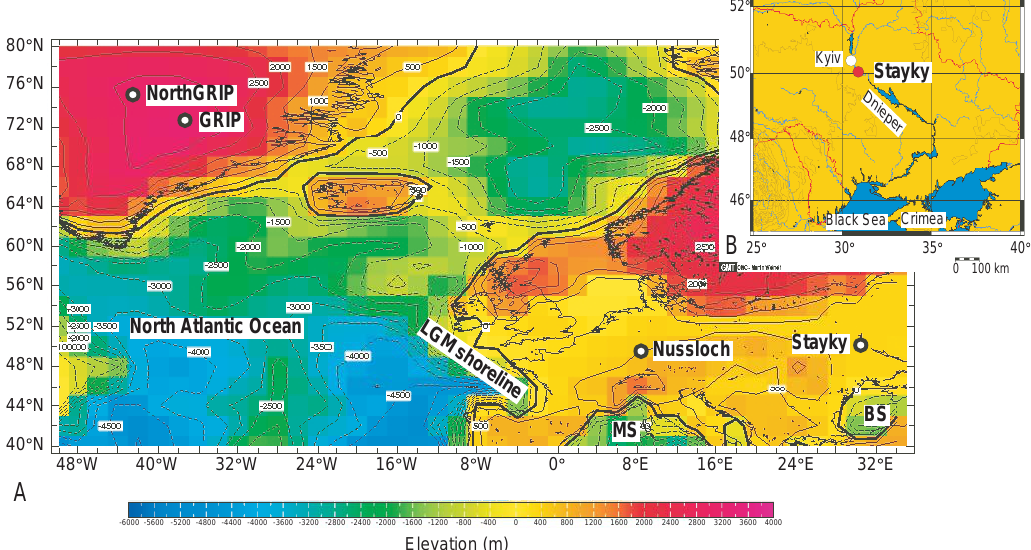
Fig. 2. Location of the studied Stayky loess sequence. (A) Map of the CLIMAP Last glacial maximum (18KBP) topography and bathymetry showing the estimated shoreline (bold line), the emerged lands, the continental ice-sheets (represented by the 1000m high line). Location of the loess series and Greenland ice-cores discussed in the text. Data from World Data Center for Paleoclimatology at 2 × 2 ◦ resolution. (B) Map of central Ukraine indicating the location of Stayky along the Dnieper River southward from